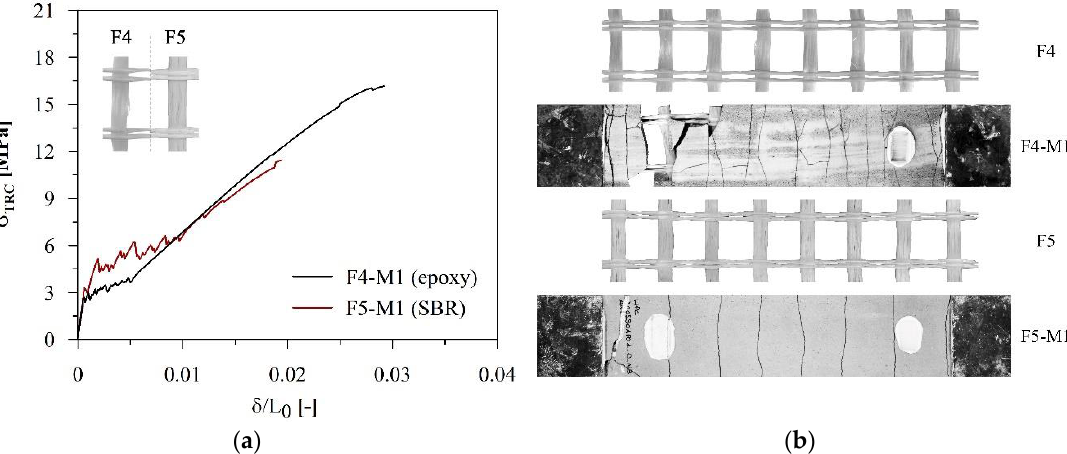
Figure 8. Effect of different coatings on the uniaxial tensile response ( a ); and on the cracking pattern ( b ) of M1-based composites reinforced with geometrically identical F4 and F5 fabrics.